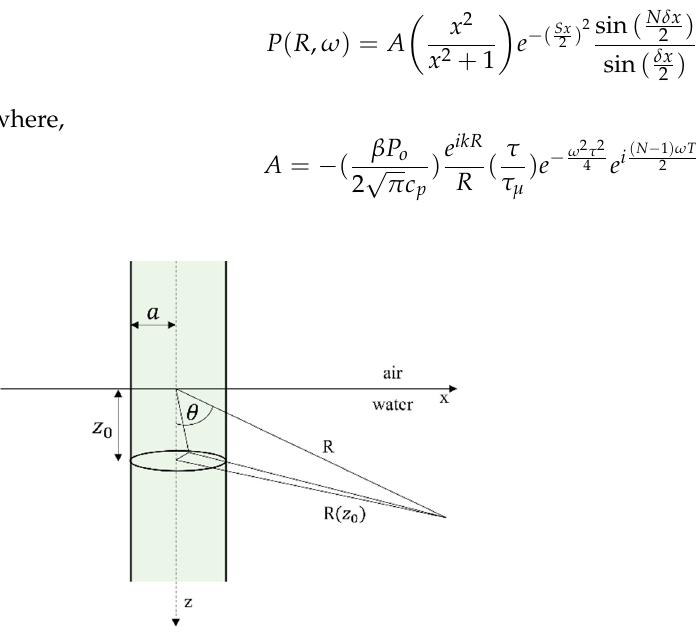
Figure 6. General geometry for linear optoacoustic mechanism (Redrawn from